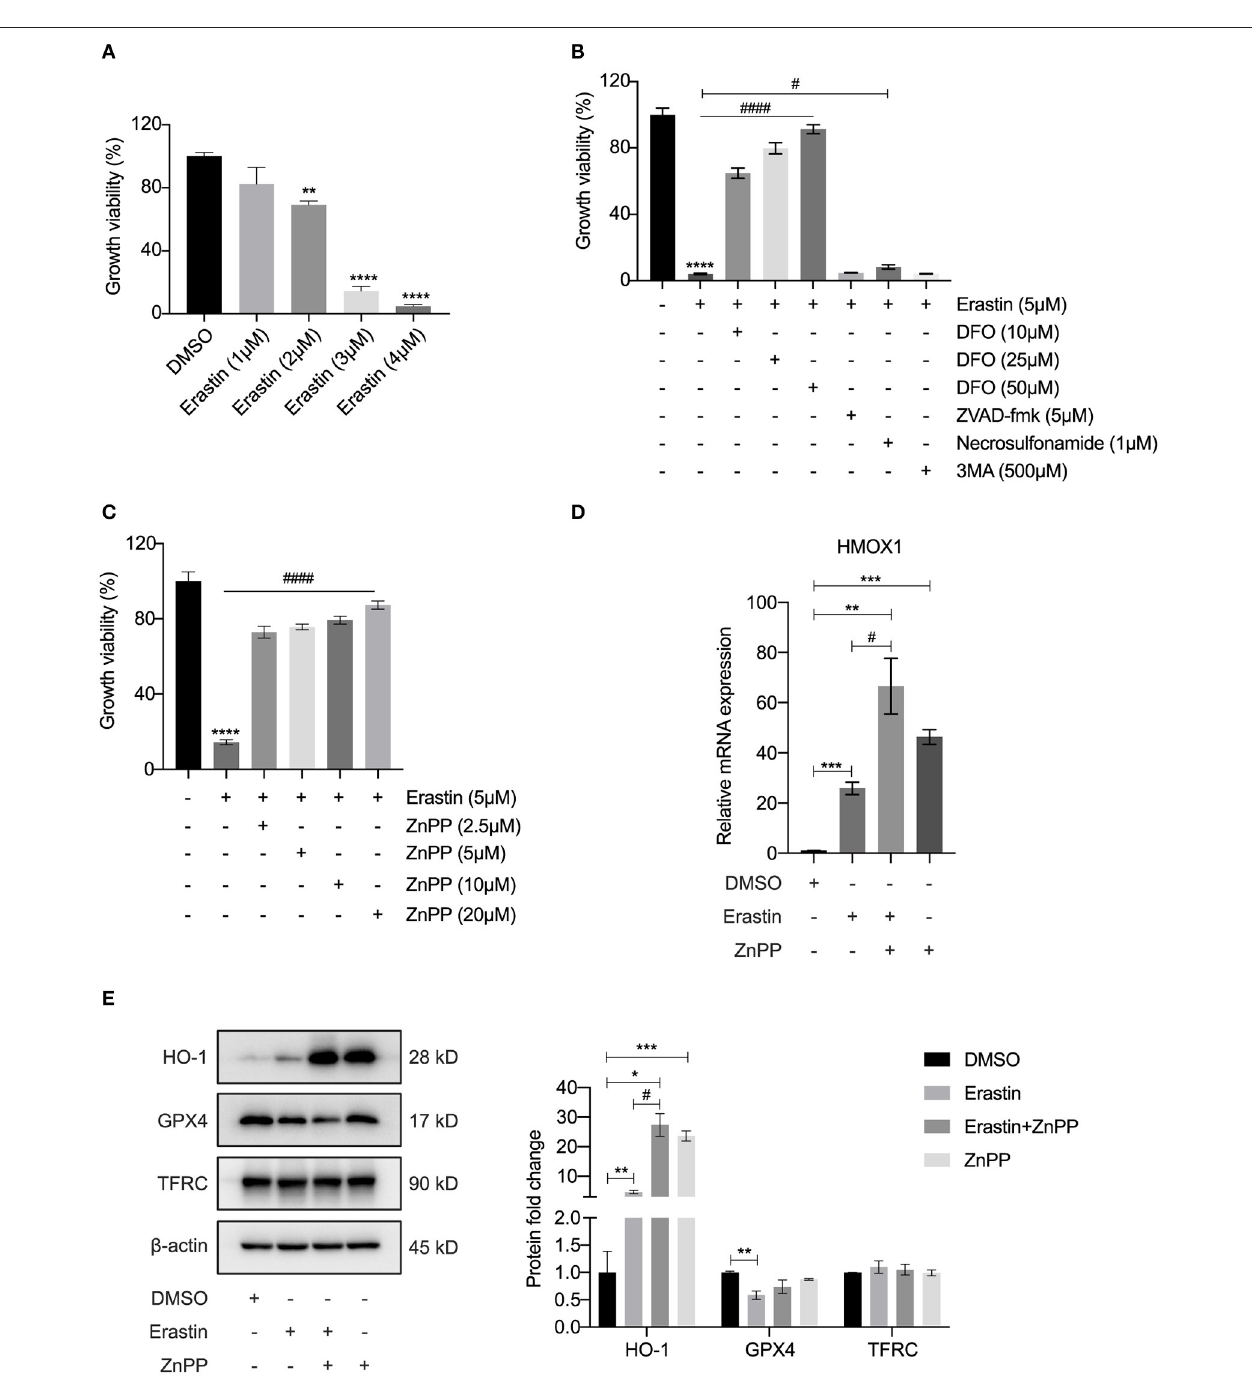
FIGURE 3 | Inhibitor of HO-1 protects HASMCs from erastin-induced ferroptosis. Growth viability of HASMCs (A) in response to different doses of erastin for 24h. Growth viability of HASMCs (B) after treatment with erastin (5 µ M) in combination with different doses of DFO or different kinds of cell death inhibitors of zVAD-fmk (5 µ M), necrosulfonamide (1 µ M) and 3MA (500 µ M) for 24h. Growth viability of HASMCs (C) after treatment with erastin (5 µ M) in combination with ZnPP, a classical HO-1 inhibitor. The mRNA content of HMOX1 (D) measured after treatment with DMSO (as control), erastin (3 µ M), erastin (3 µ M) combined with ZnPP (5 µ M) or ZnPP (5 µ M). Representative western blot images and quantitative analysis results (E) of HO-1, GPX4 and TFRC proteins after treatment with DMSO (as control), erastin (3 µ M), erastin (3 µ M) combined with ZnPP (5 µ M) or ZnPP (5 µ M). (The error bars represent standard error of mean from three replicates. # p < 0.05, #### p < 0.0001, * p < 0.05, ** p < 0.01, *** p < 0.001, **** p < 0.0001, compared between the groups by t -test).